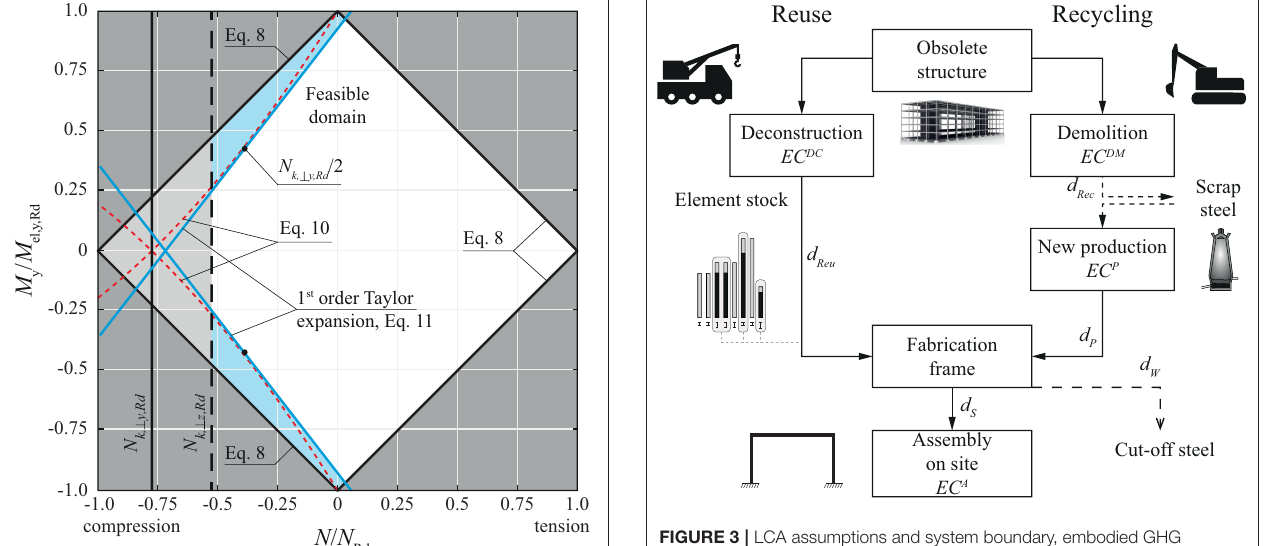
FIGURE 3 | LCA assumptions and system boundary, embodied GHG emission coefficients (EC), transport distances ( d